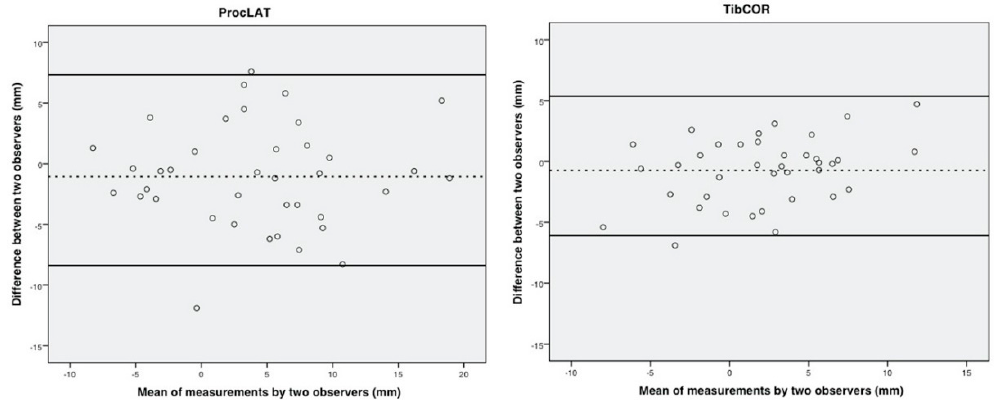
Figure4. BlandAltmanPlots. BlandandAltmanplotsdepictingtheprocLATandtibCORmeasurements